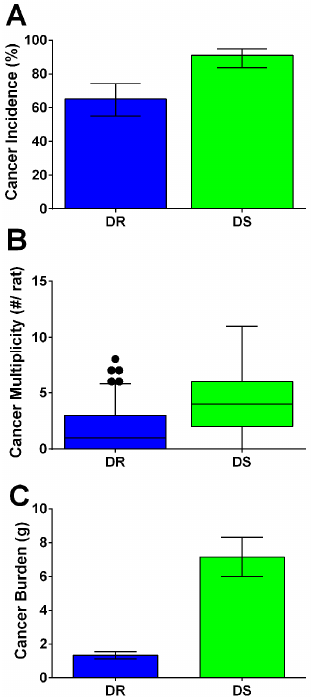
Figure 1. Obesity accelerates mammary carcinogenesis in dietary obesity sensitive (DS)